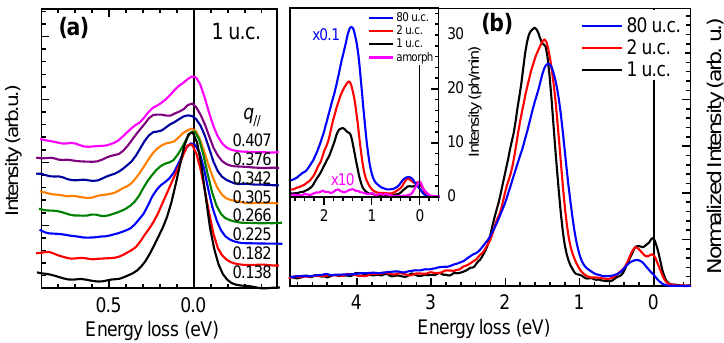
Figure 3. Panel ( a ) RIXS measurements of magnetic excitations in 1 u.c.-thick NdBa 2 Cu 3 O 7 − x film as a function of momentum transfer q (cid:107) . Panel ( b ) Comparison between the RIXS spectra at q (cid:107) = 0.376 r.l.u. of 1, 2 and 80 u.c.-thick NdBa 2 Cu 3 O 7 − x films after normalization to the area of the dd excitations. Also shown is the RIXS spectrum of a 2.4 nm-thick amorphous layer of NdBa 2 Cu 3 O 7 − x , rescaled by a factor 10. The inset shows the same data normalized to the acquisition time.